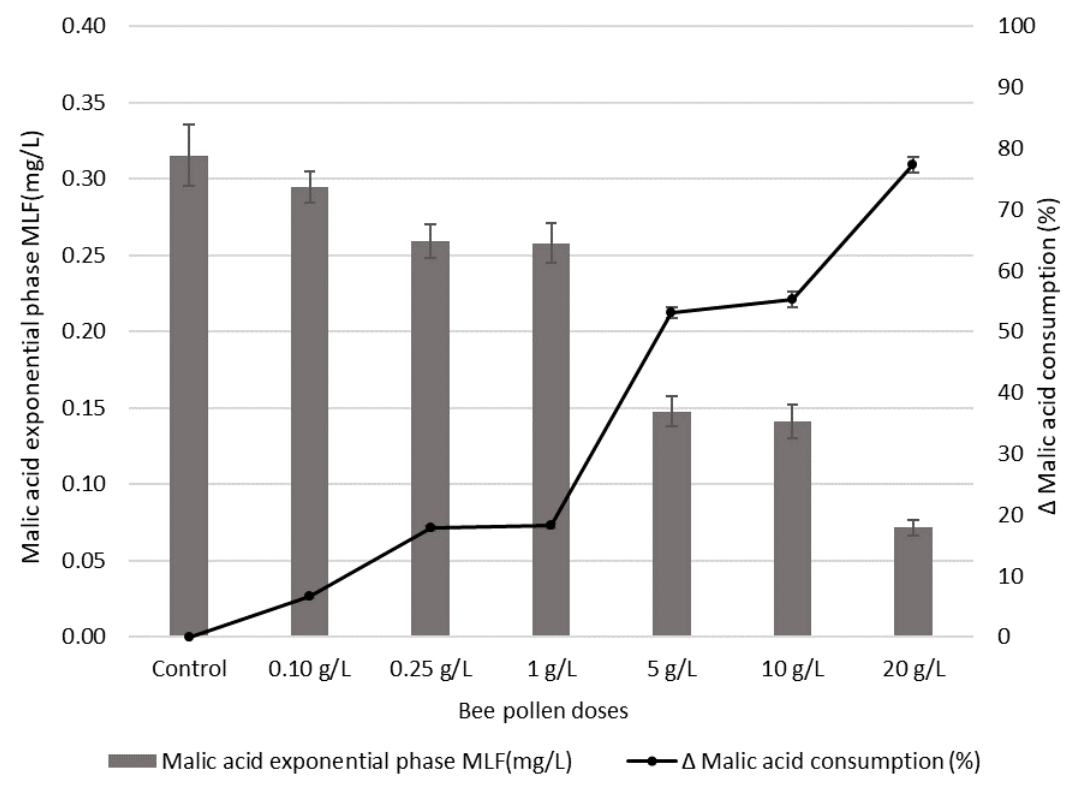
Figure 7. Malic acid concentration during the exponential phase of bacterial growth, as opposed to the increase in consumption speed (%).